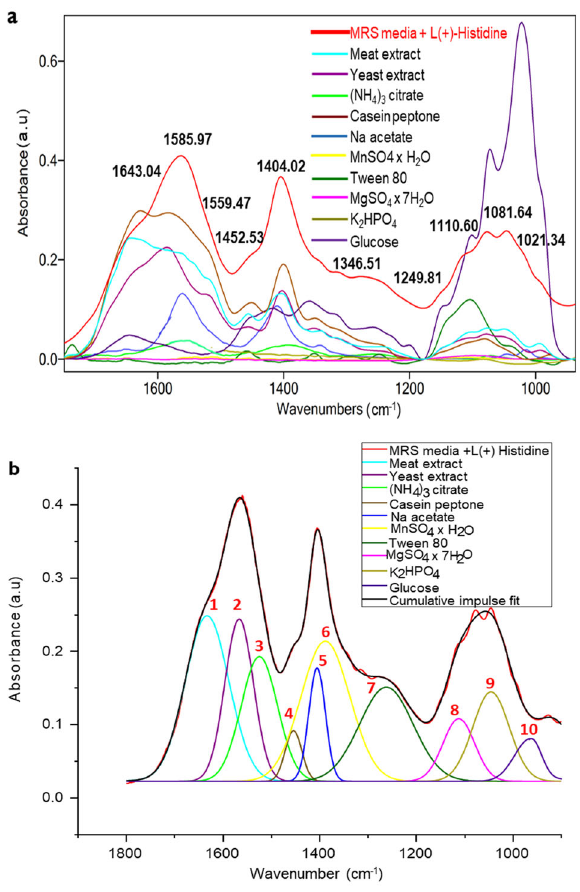
Fig. 7 Deconvolution of IR spectra for unraveling molecular details during bio fi lm formation. a IR-ATR spectrum of MRS medium supplemented with 5 mM L ( + ) L-histidine (red) and experimentally obtained spectra of the individual constituents in the spectral region from 1800 to 900 cm − 1 (see color code, top, middle). b Resulting cumulative impulse fi t (black) and fi tted IR signatures of the individual constituents (see color code, top, right). The integration values (peak center and width) of the individual components (see Table 2) served as restrictions for the cumulative impulse fi t ( n ≥ 10; Gaussian fi t). The experimentally obtained sum spectrum is given in red in ( a ) and ( b